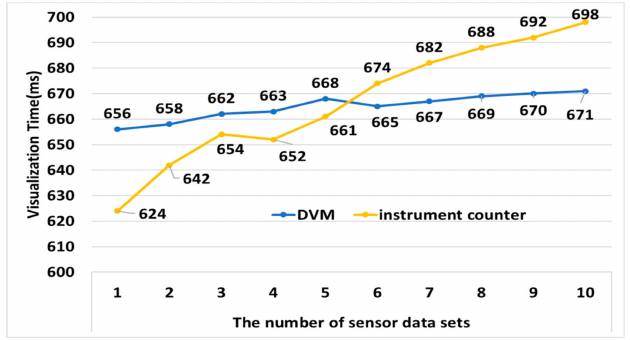
Figure 14. Performance analysis of